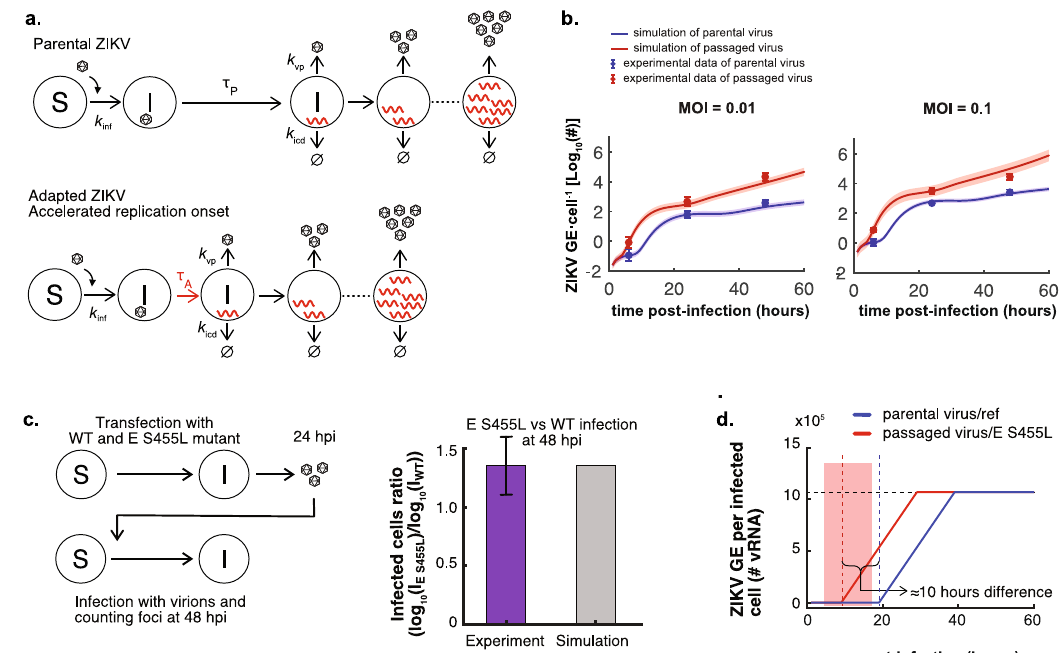
Fig. 5 Multiscale model of ZIKV infection and replication, with differences in the delay between infection to replication. a Schematic representation of the model. ZIKV infects susceptible cells with rate k inf . Productive viral replication begins with a time delay τ P for the parental virus and τ A for the evolved or mutated viruses. Virus replication within infected cells is modeled as a piecewise linear function approximating virus replication (Supplementary note 1, mathematical model). Infected cells produce virions with rate k vp , and die with rate k icd . b Model simulation with optimized parameters versus experimental measurements of the number of ZIKV genomes per cell upon infection with different doses of parental and adapted ZIKV. c Model simulation versus experimental measurements of the ratio of the infected cells upon infection with wild type and the E S455L mutant ( I E S455L / I WT ). Left panel, schematic representation of the procedure for the multiscale model in accordance with the experimental method used in the transfection experiments including analyses of the extracellular infectivity. d Simulation of the ZIKV replication inside the infected cells for parental/ref and adapted/E S455L mutant. The shaded region is the 95% CI for the estimated τ A